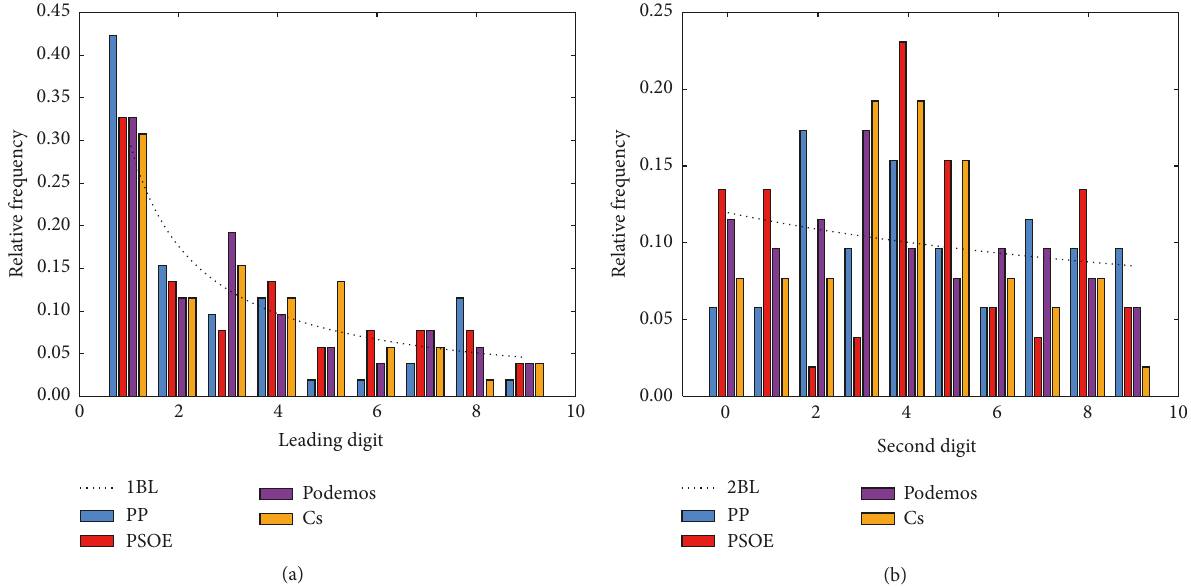
Figure 15: Histograms of relative frequencies for the first (a) and second (b) significant digits for the main political parties vote counts aggregated over precincts, for the case of